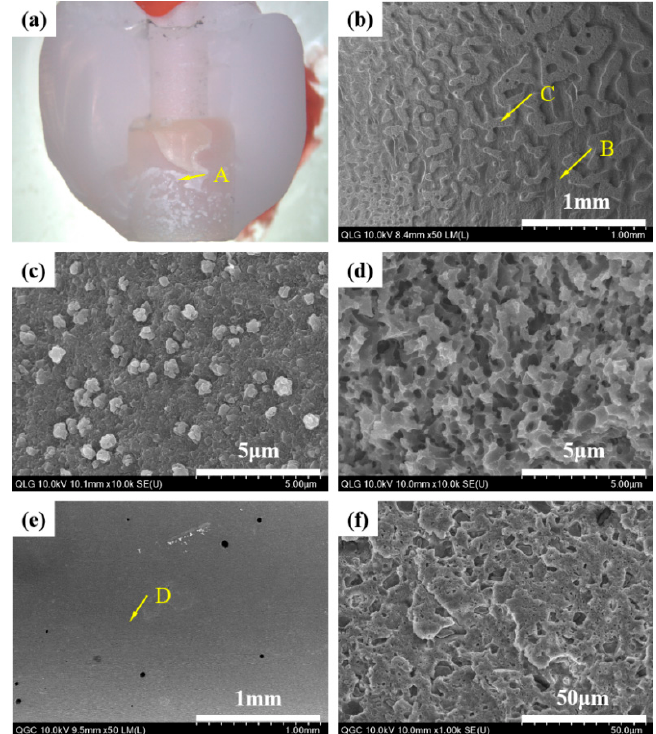
Figure 9. Photographic ( a ) and HR FE-SEM images of the lithium disilicate-reinforced glass ceramic crown that demonstrate the mode of failure; ( b ) the magnification of point A for the (milled, liner-bonded and glazed) MLG group: Inhomogeneous pattern of fracture surface; ( c ) the magnification of point B: Cohesivefractureoccurredthroughtheliner; ( d )themagnificationofpointC:Adhesivefractureoccurred at the interface with liner, and ( e ) magnification of point A for the milled, glazed, and cement-bonded (MGC) group: Homogeneous pattern of fracture surface; ( f ) the magnification of point D: Cement layer indicating adhesive fracture occurred at the interface with the zirconia ceramic